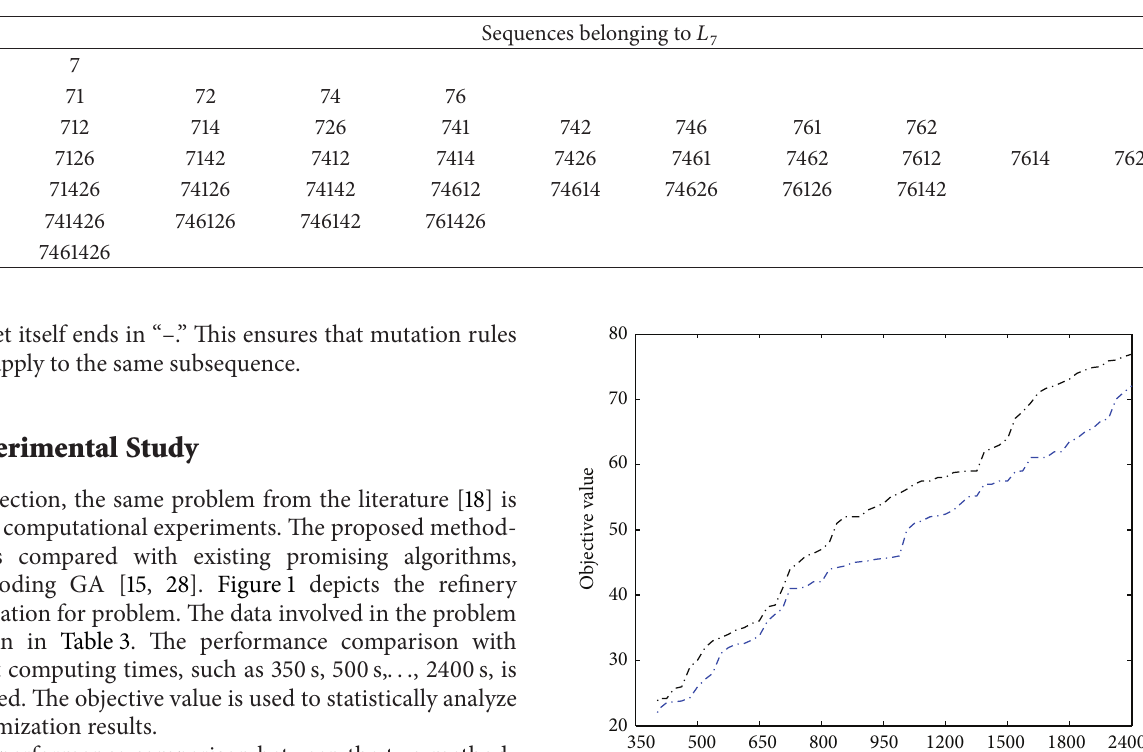
Algorithm 3: An example to demonstrate the mutation rules. Table 1: Subsequence belonging to 𝐿 7 .